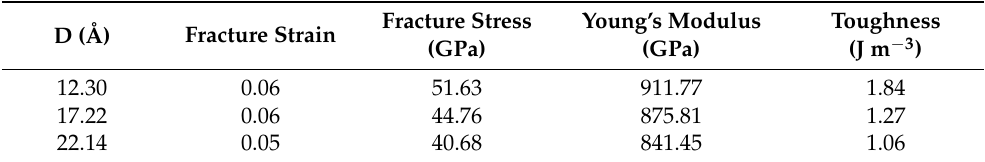
Table 3. Quasi-hexagonal crack.